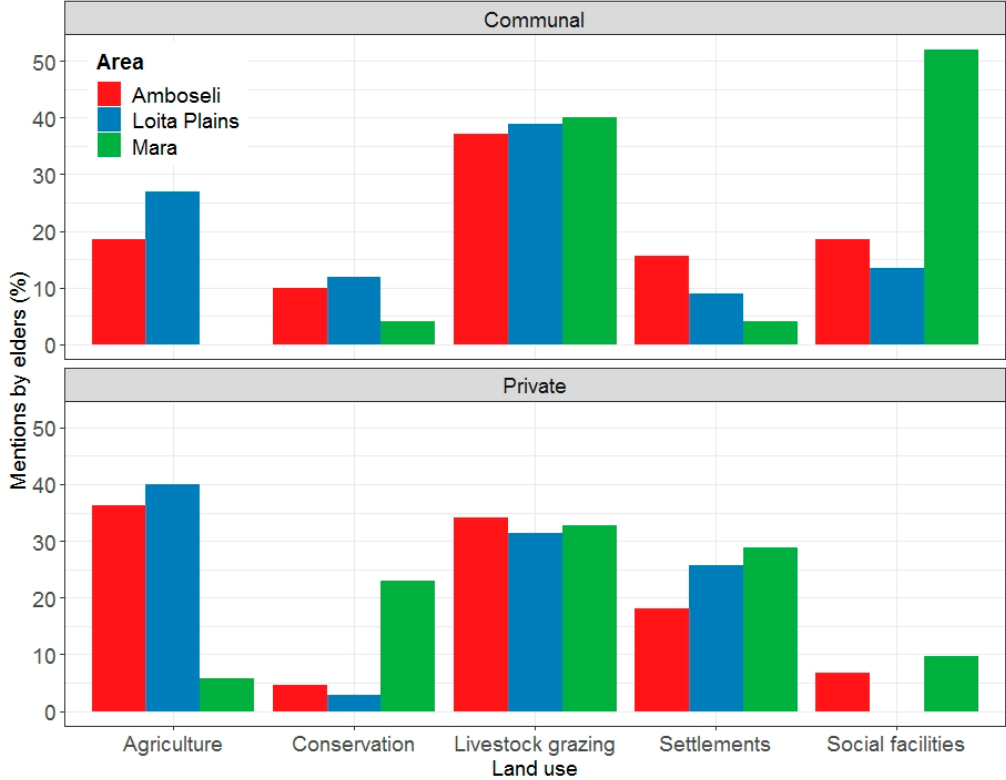
Figure 3. Land uses in communal and private across land tenure types as mentioned by community elders in Amboseli, the Loita Plains, and Mara ecosystems in southern